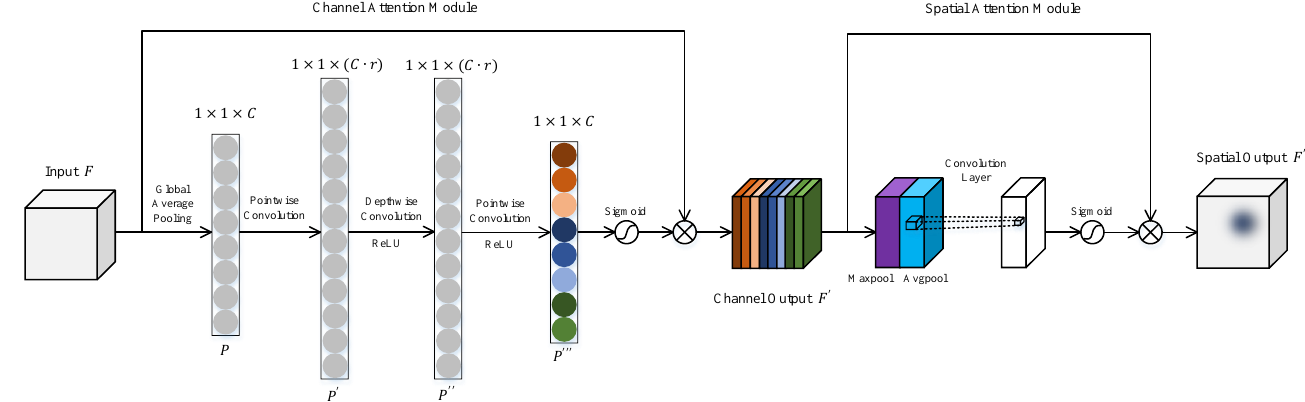
Figure 3. Schematic of Inverted Residual Attention Module